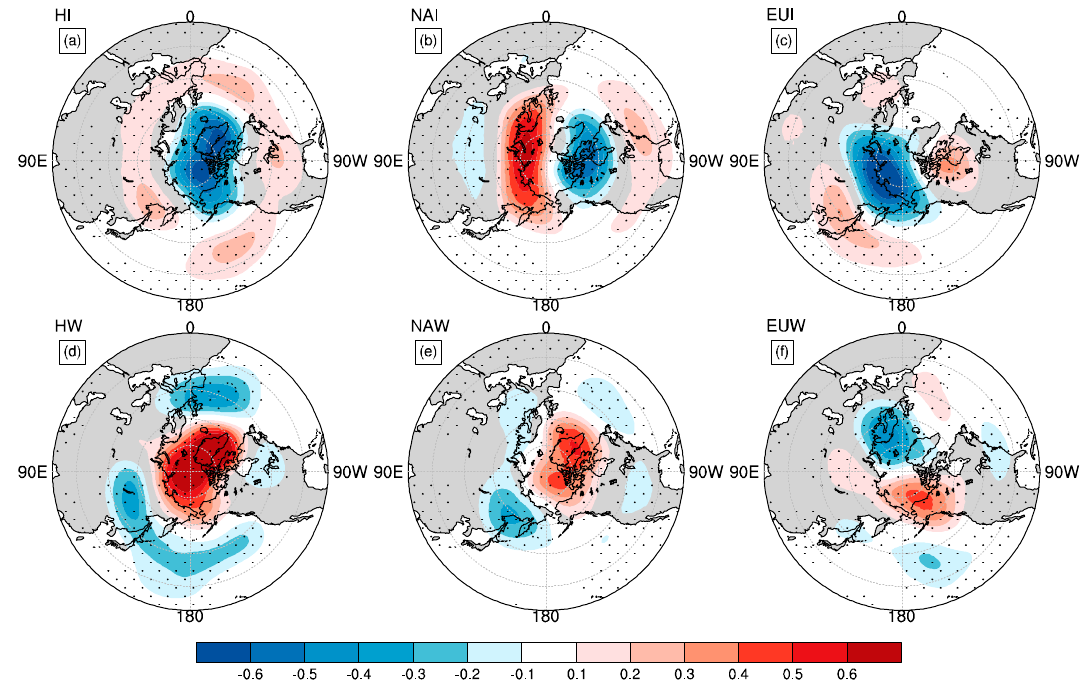
Figure 3. ( a – f ) Composited standardized 500 hPa height anomalies for the six stratospheric Arctic vortex weather regimes (shading) over 20–90 ◦ N based on the historical run. The dotted area marks the composited anomalies at the 99% confidence level based on a two-sided Student’s t-test.